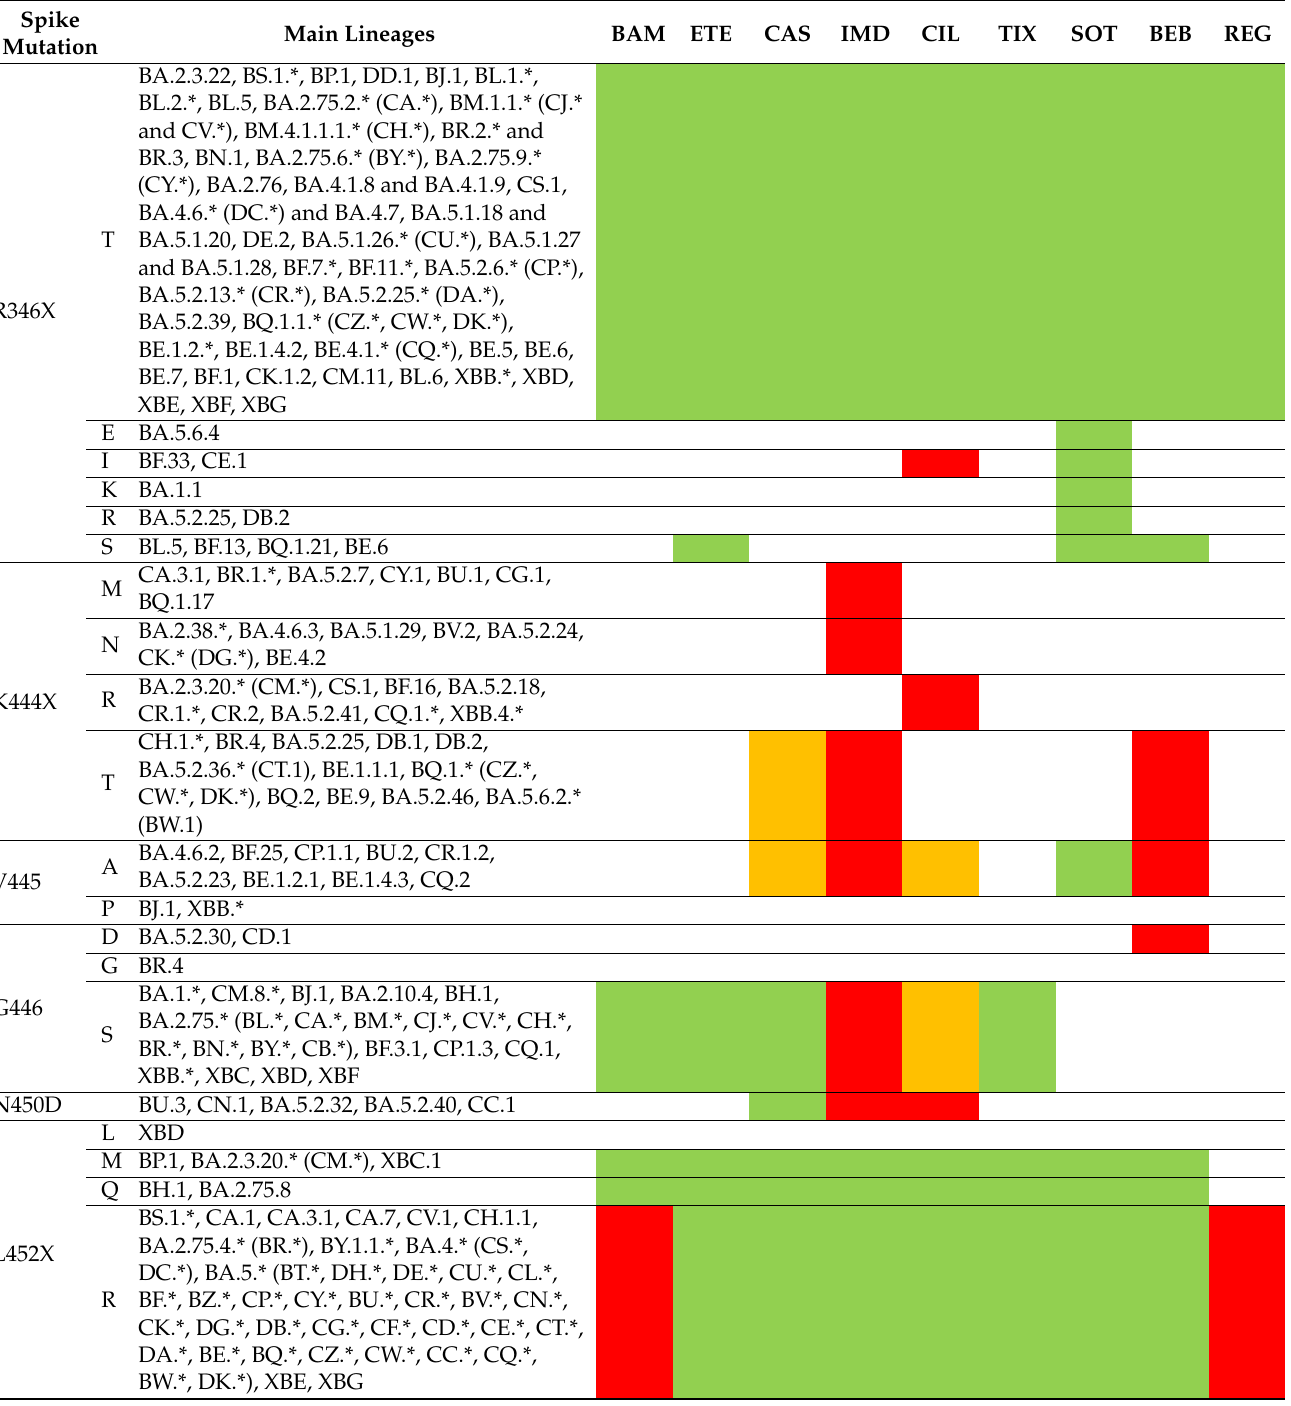
Table 1. Heatmap of selected Spike RBD mutations in Omicron sublineages and their impact on authorized therapeutic anti-Spike mAbs. BAM: bamlanivimab; ETE: etesevimab; CAS: casirivimab; IMD: imdevimab; TIX: tixagevimab; CIL: cilgavimab; SOT: sotrovimab; BEB: bebtelovimab; REG: regdanvimab. Data sourced from the Stanford University Coronavirus and Antiviral Resistance Database (accessed online at https://covdb.stanford.edu/search-drdb (accessed on 30 November 2022)). Green means fold-reductions <5; Orange means fold-reduction 5–100; Red means fold- reduction in IC 50 > 100 compared to wild-type; blank means no data